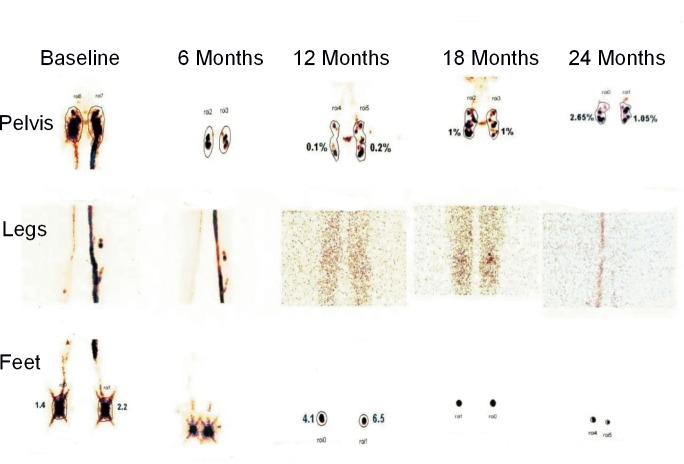
Post treatment reversibility in a 12 year old asymptomatic male.Images show lymphatic flow obstruction on left leg at baseline, with complete reversal apparent at 1 year & sustained at 18 & 24 Months.